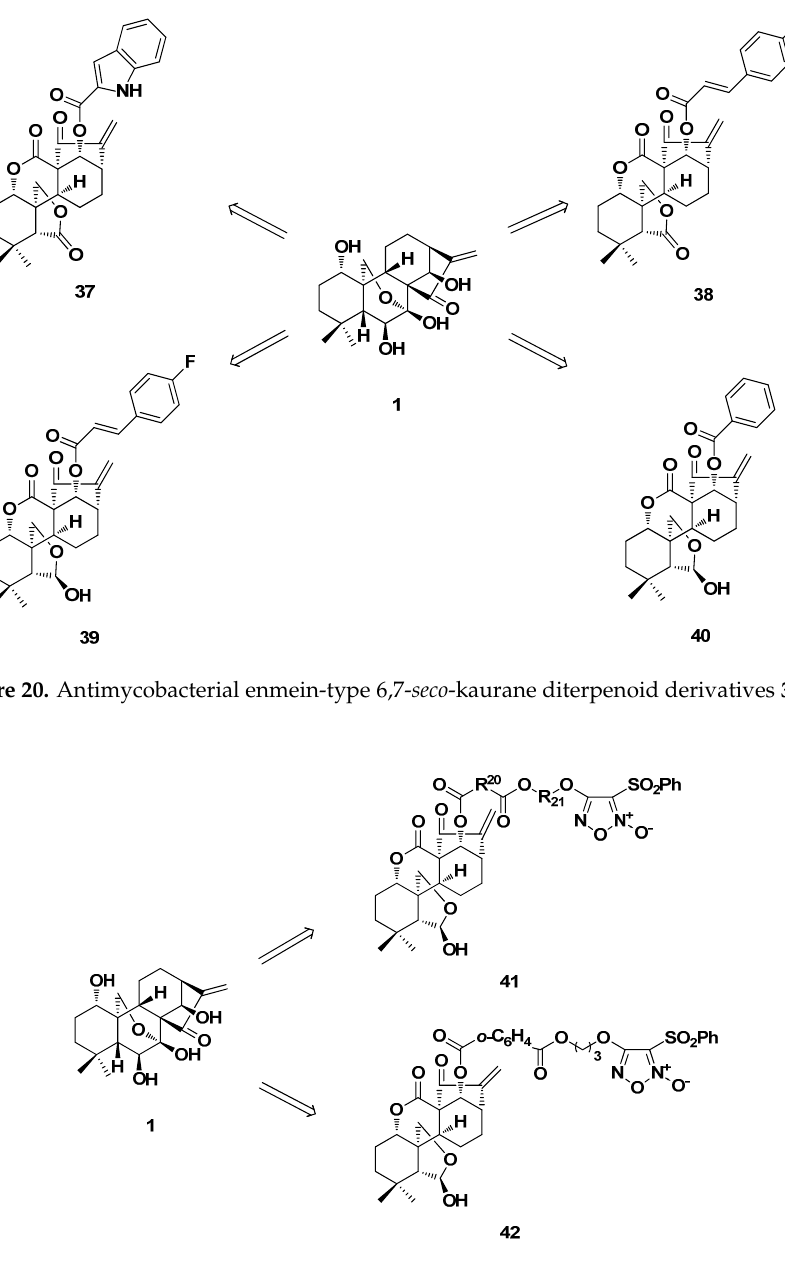
Figure 21. NO-releasing enmein-type 6,7- seco -kaurane diterpenoid derivatives 41 and 42 .